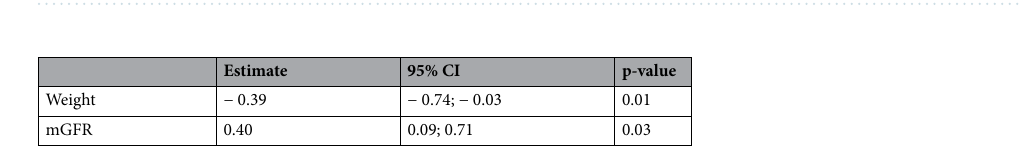
Table 3. Multivariable model summary for post-operative mGFR. For this model, intercept was 64.8 [18.9– 110.6] and adjusted R 2 was 0.44.